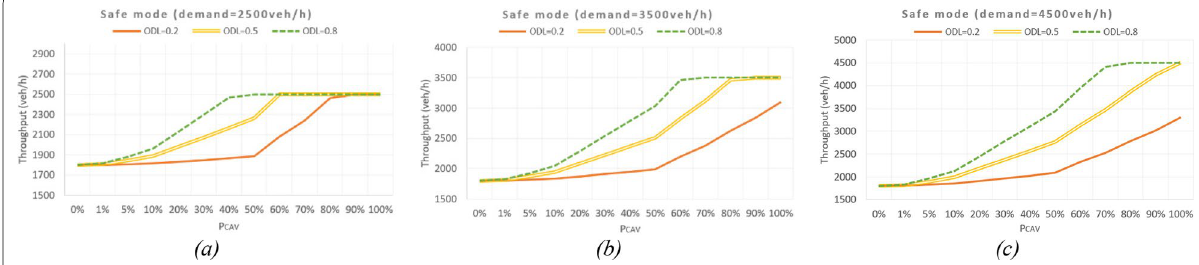
Fig. 5 Traffic throughput with different O DL on a two-lane freeway under the safe mode and different traffic